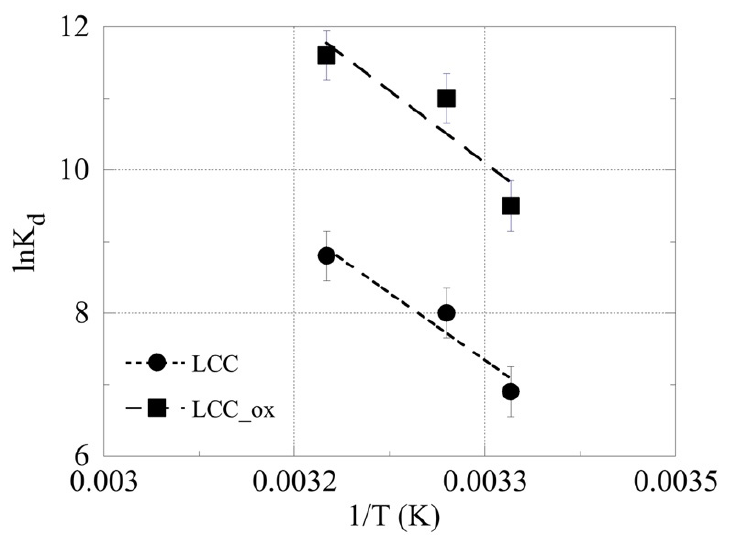
Figure 6. The ln K d as a function of 1/T for the sorption of U(VI) by LCC and LCC_ox, at an initial uranium concentration of 8.6 × 10 − 14 mol/L, biochar mass = 0.01 g, pH 4 and 3 days of contact time.